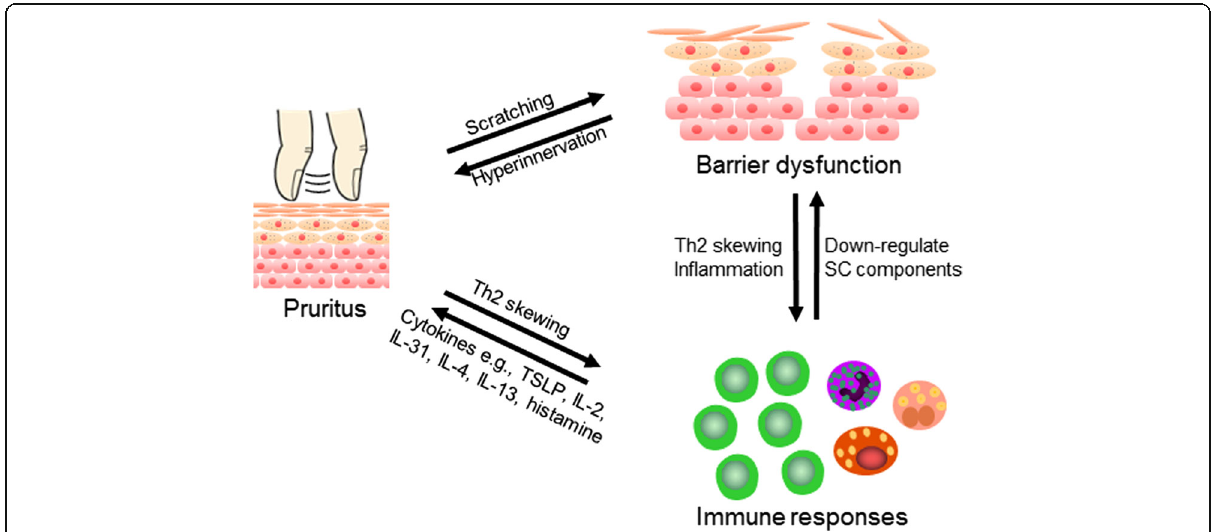
Fig. 3 The relationship among itch, barrier disruption and an immunologic aberration. Scratching resulting from itch can worsen a breach in the skin. Dry skin promotes itch by increasing the density of epidermal nerve fibers. Scratching also promotes Th2 chemokines, eosinophil-recruiting chemokines, and thymic stromal lymphopoietin (TSLP). Conversely, immune responses can induce itch via the secretion of a myriad of cytokines that can act as